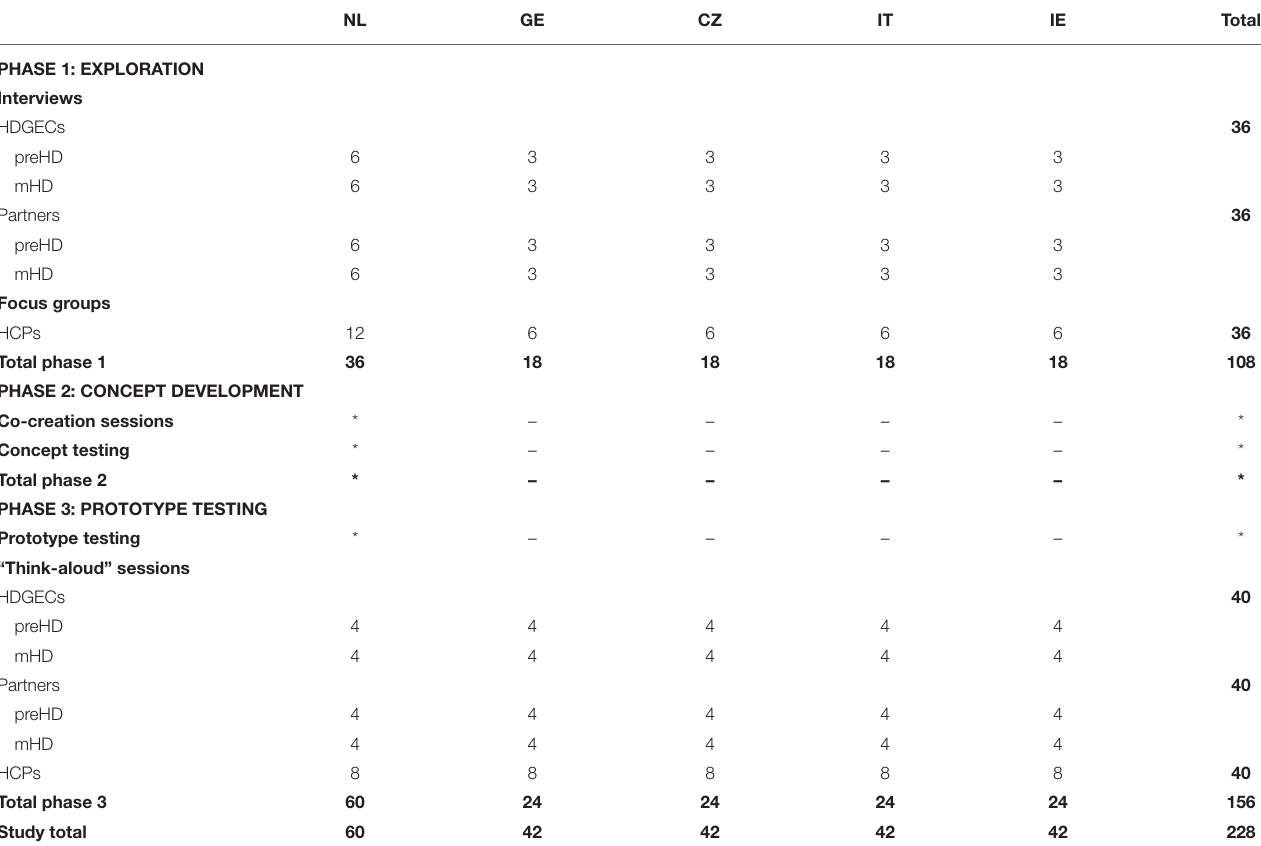
TABLE 3 | Estimated number of participants per UCD phase per country. NL GE CZ IT IE